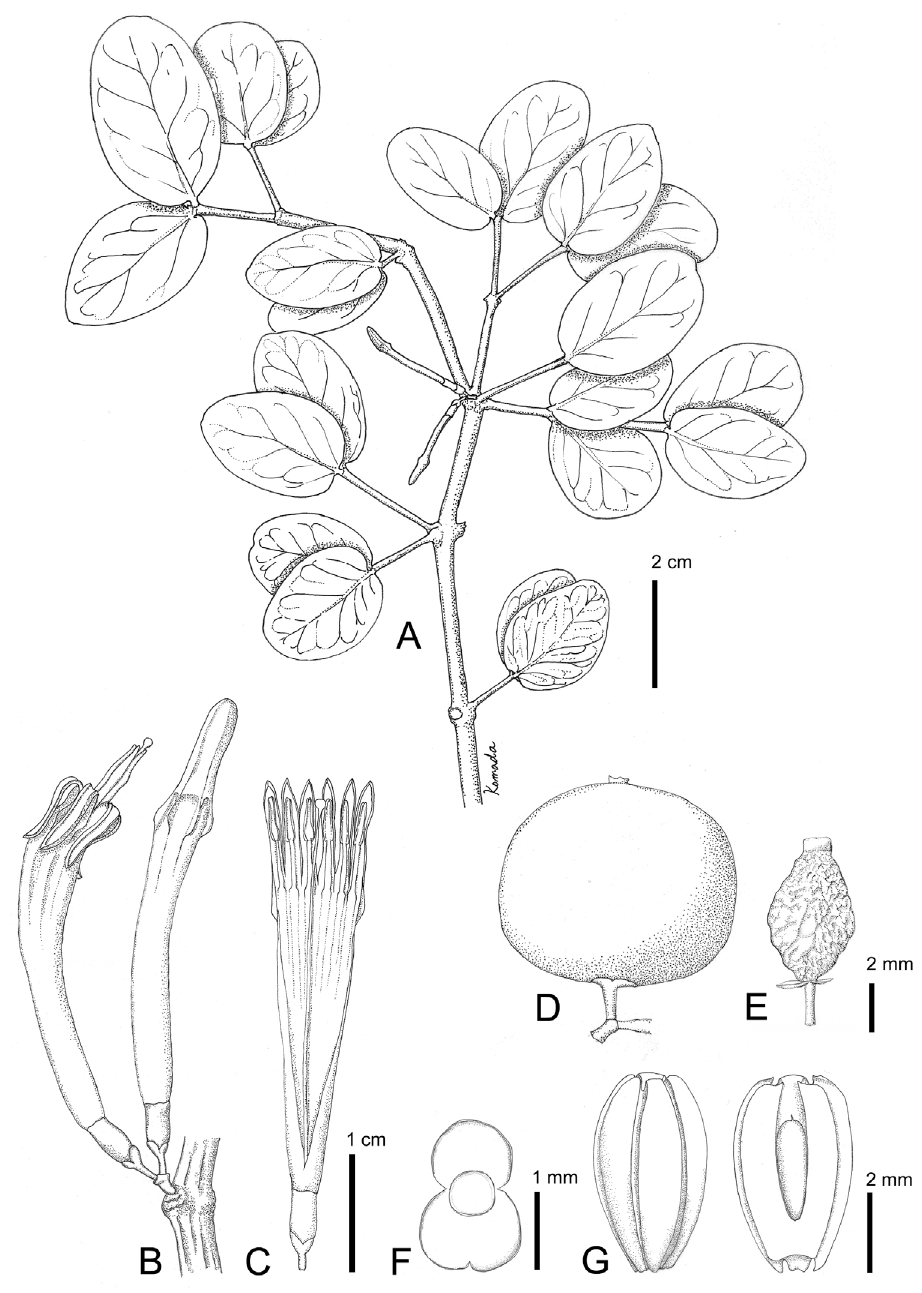
Figure 1. Macrosolen bidoupensis Tagane & V.S.Dang. A Branch with flower buds B 2-flowered inflores- cence C Flower with corolla tube opened D Fresh fruit E Dried fruit F Seed G seed (left) and longitudinal section of seed (right). Materials: Tagane et al. V4083 (KYO). Drawn by N.